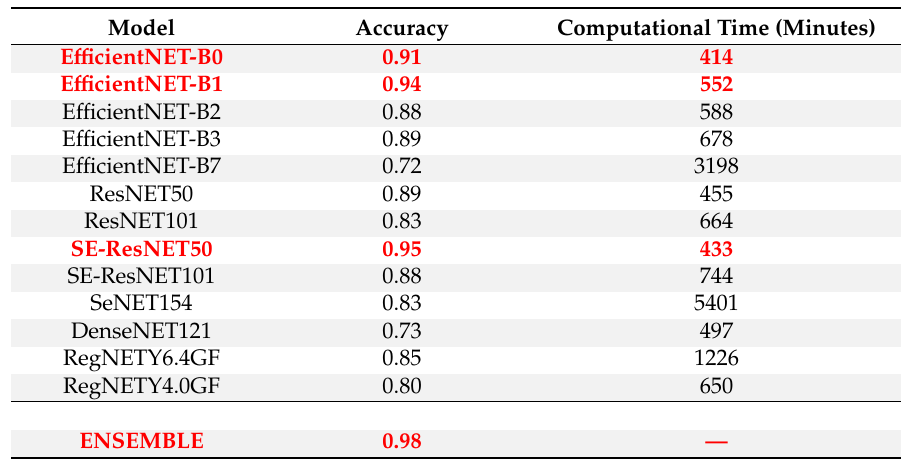
Table 1. Convolutional Neural Networks (CNNs) accuracy on the test dataset and computational time to train each